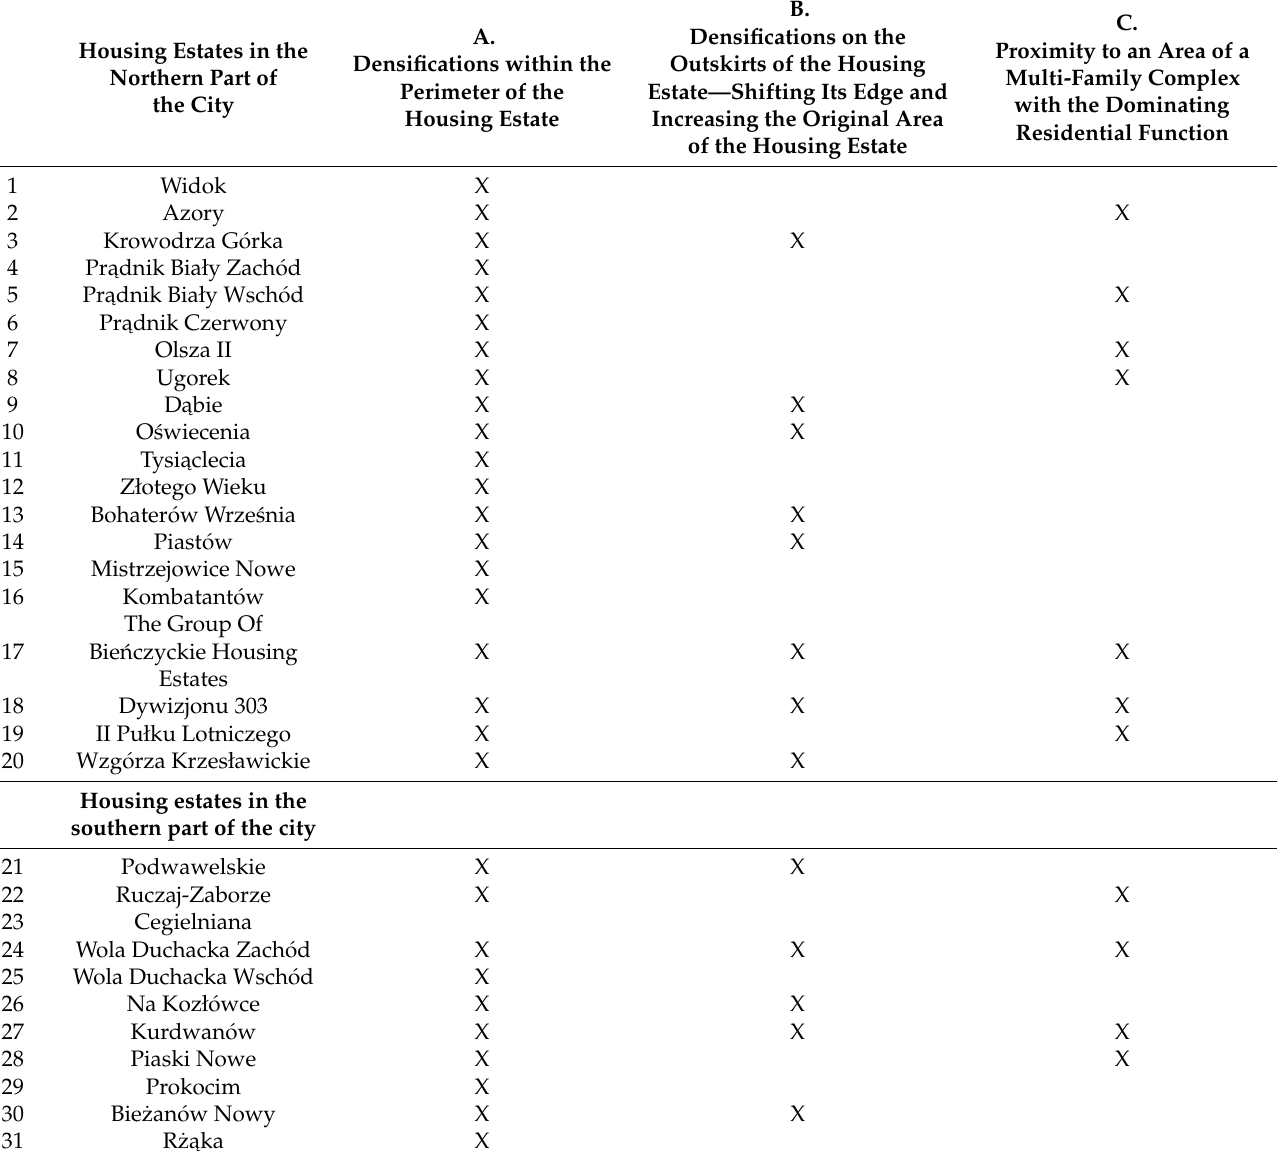
Table 3. Characteristics of the way new buildings are introduced within the perimeter and in areas adjacent to large-panel housing